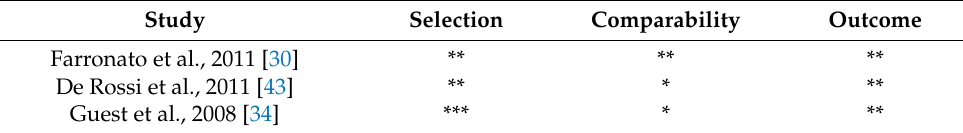
Table 5. Assessment of the risk of bias in the